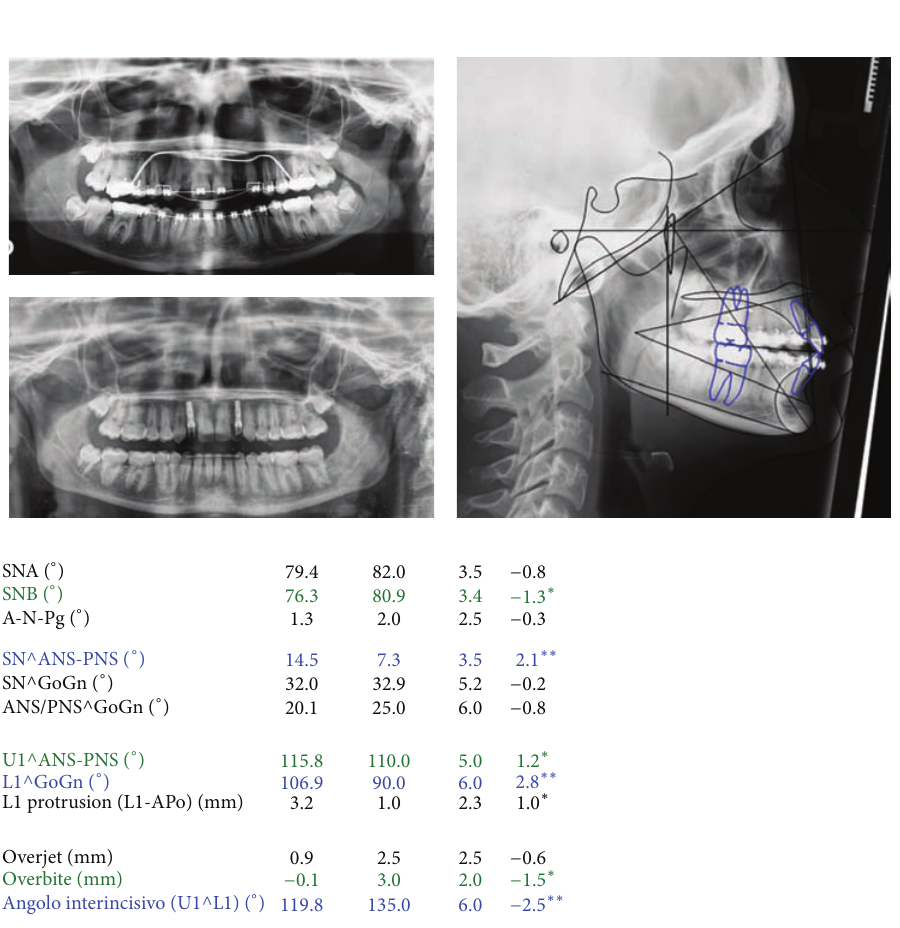
Figure 8: Cephalometric values just before the end of treatment and panoramic radiograph before final debonding and after implant placement. From left to right: value measured, average value from the population norm, standard deviation of the average value from the population norm, and difference from the extreme value of the population norm. Blue: values above the norm; green: values below the norm; black: values within the